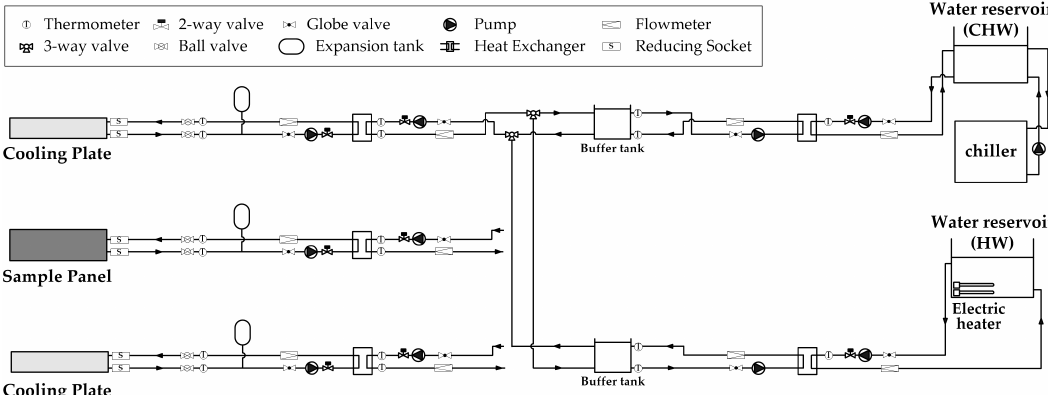
Figure 7. The configuration of the heat production system and the hydraulic